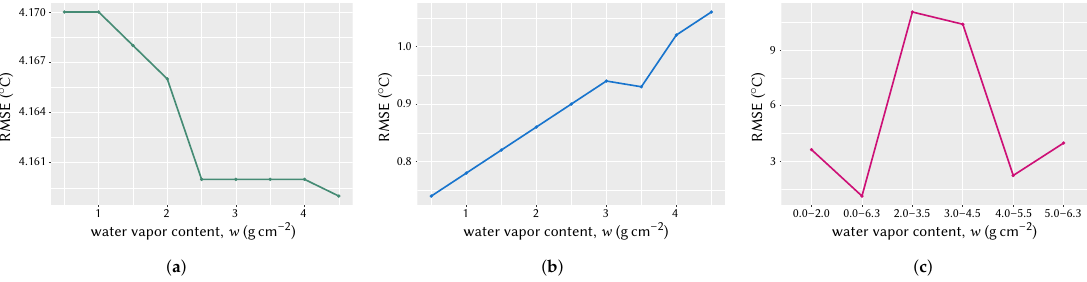
Figure 11. Variation of RMSEs with water vapor content: ( a ) using Single-Channel algorithm for Landsat 8 TIR band 10, ( b ) Split-Window algorithm and coefficients according to Jiménez-Muñoz et al., and ( c ) Split-Window algorithm and coefficients according to Du et